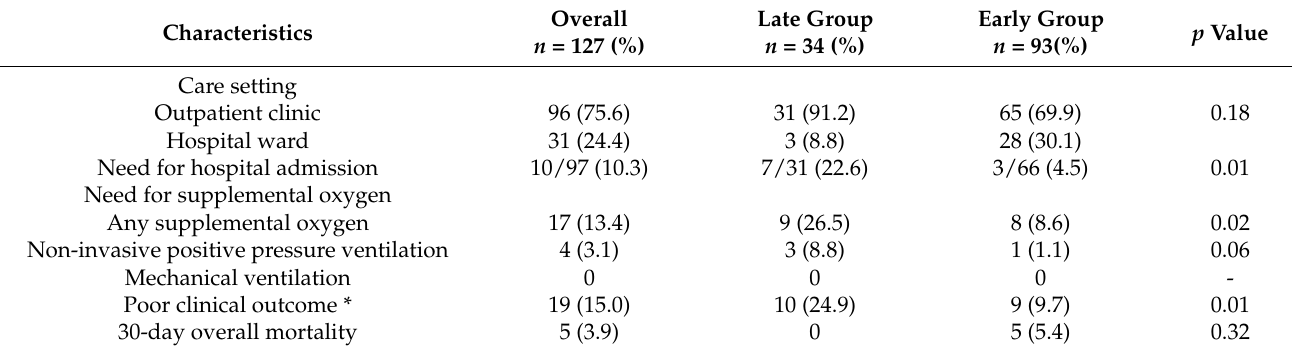
Table 2. Comparison of care setting and clinical outcomes of patients receiving early ( n = 93) or late ( n = 34) bamlavinimab and etesevimab combination therapy.